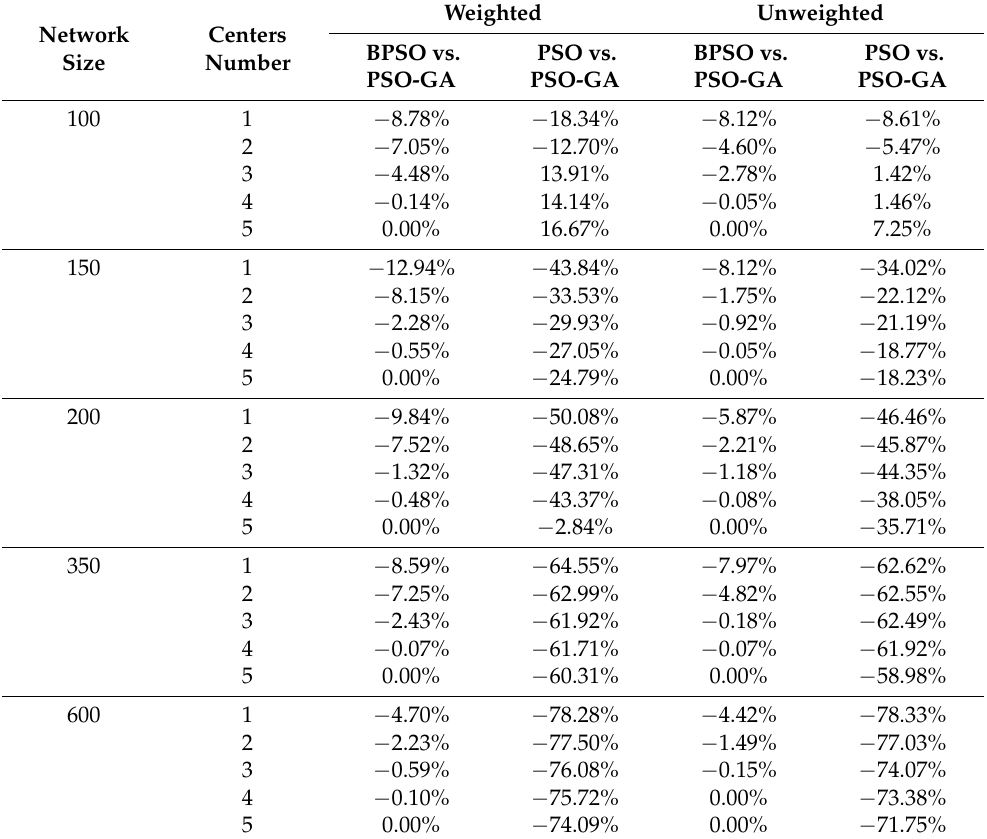
Table 9. The comparative solution time comparison for weighted and unweighted networks of each solver. Network Size